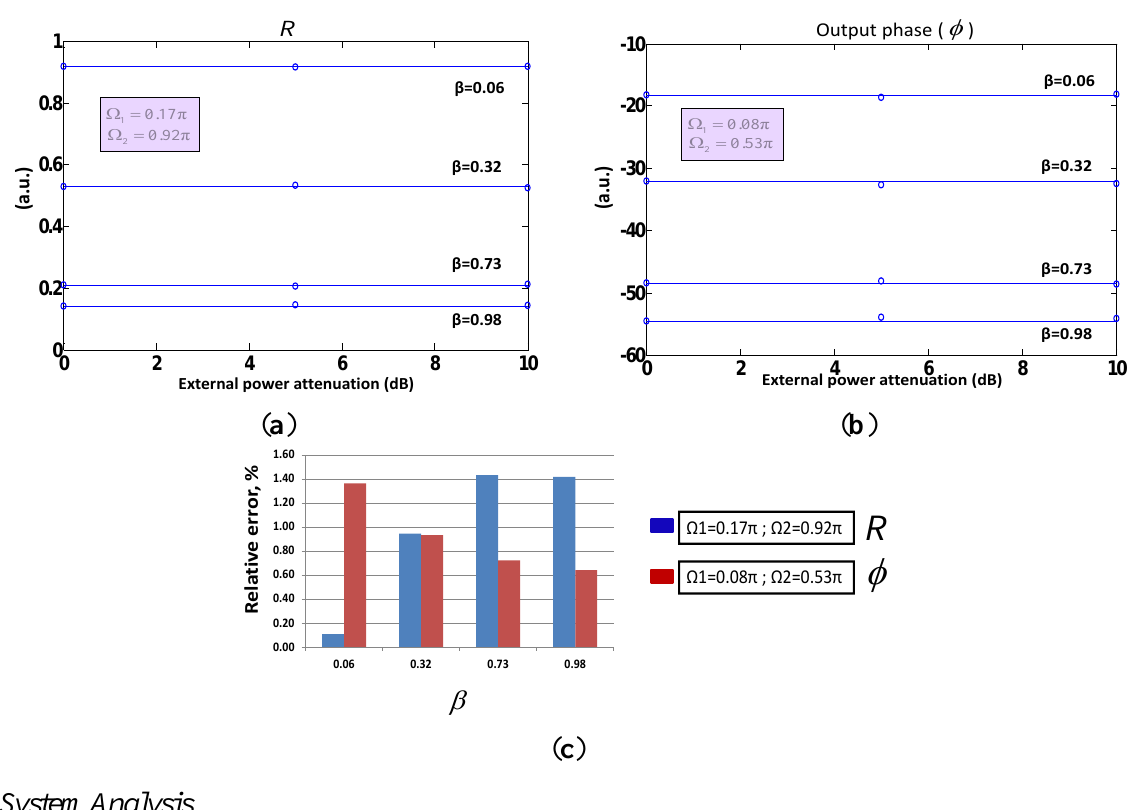
Figure 6. Self-reference test of both measurement parameters versus induced power losses (up to 10 dB) for different values of β . Figure Inset: relative error (%) of the measurements.